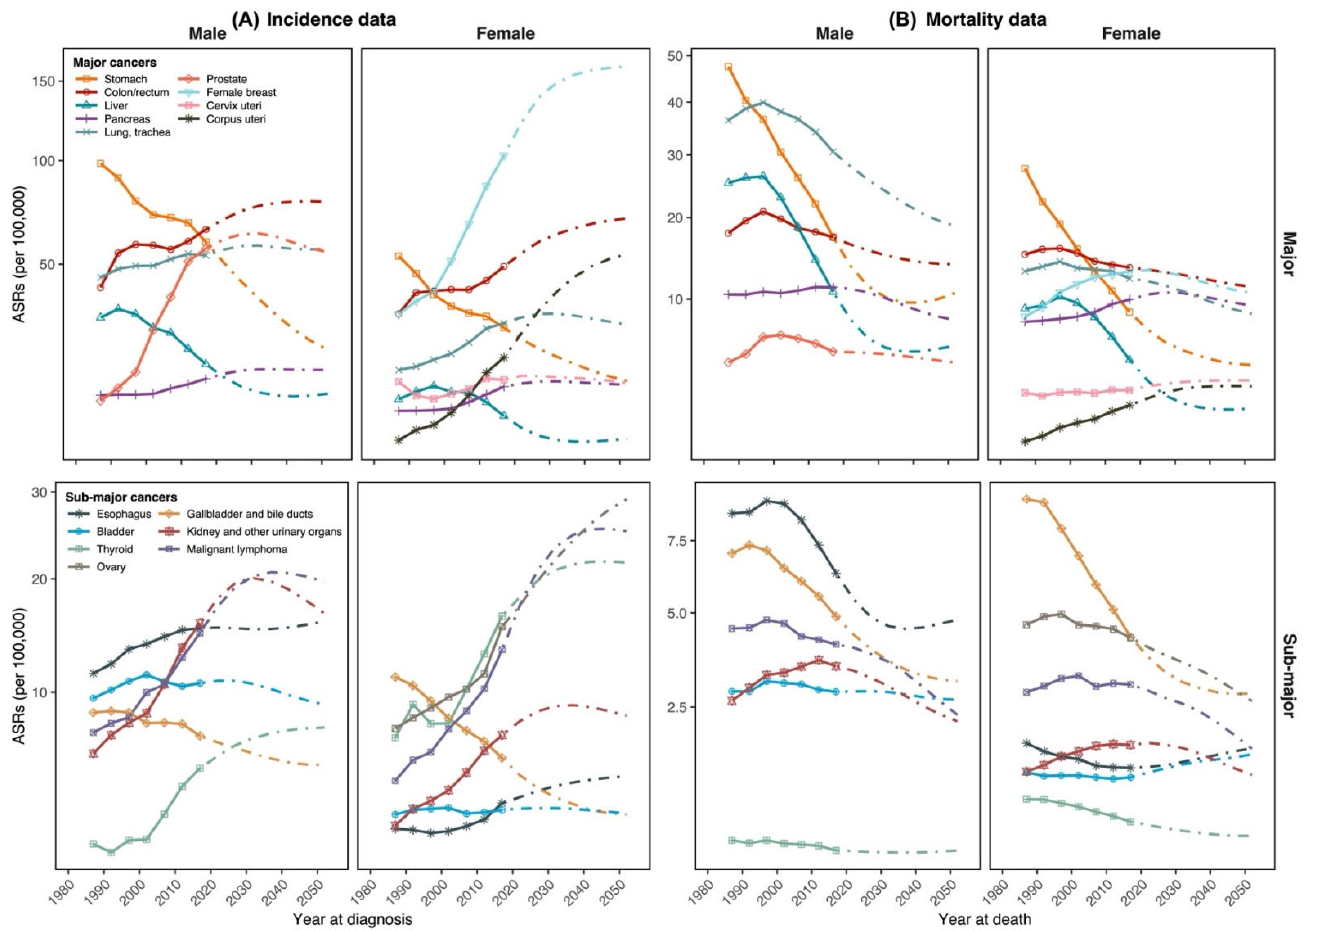
Figure 2. Projections of age-standardized incidence and mortality rates for major and sub-major cancer sites by gender, 1985–2054. ( A ) Incidence data and ( B ) Mortality data.